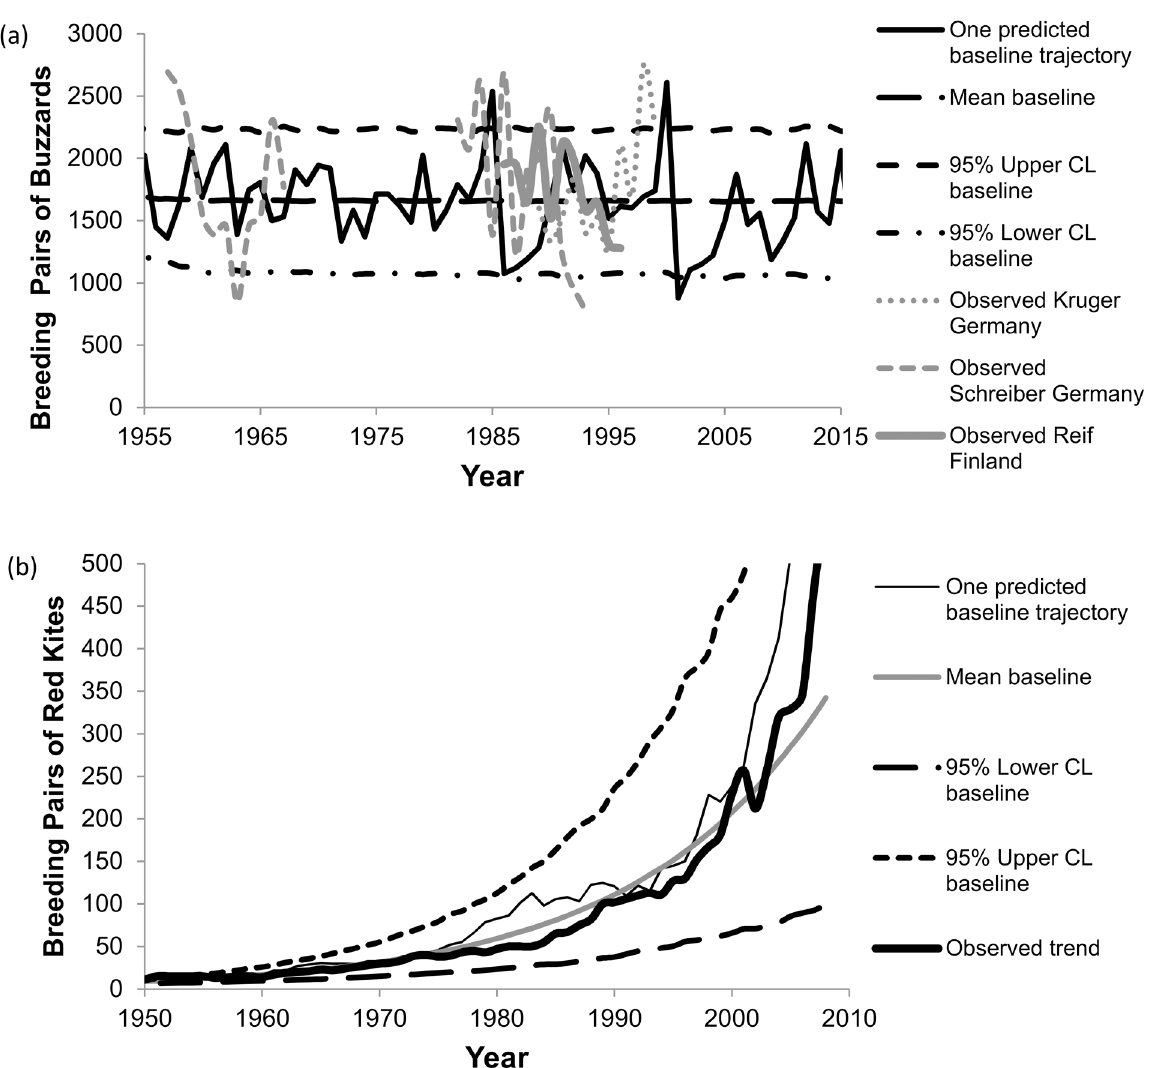
Fig 3. Comparison of the baseline-model population trend (mean and its 95% confidence limits) to the observed population trajectories of (a) common buzzards and (b) red kites. One typical stochastic-predicted trajectory is also included to show the variation being modeled. The three observed trajectories are from Reif et al. [42], Schreiber et al. [43], and Krüger and Lindström